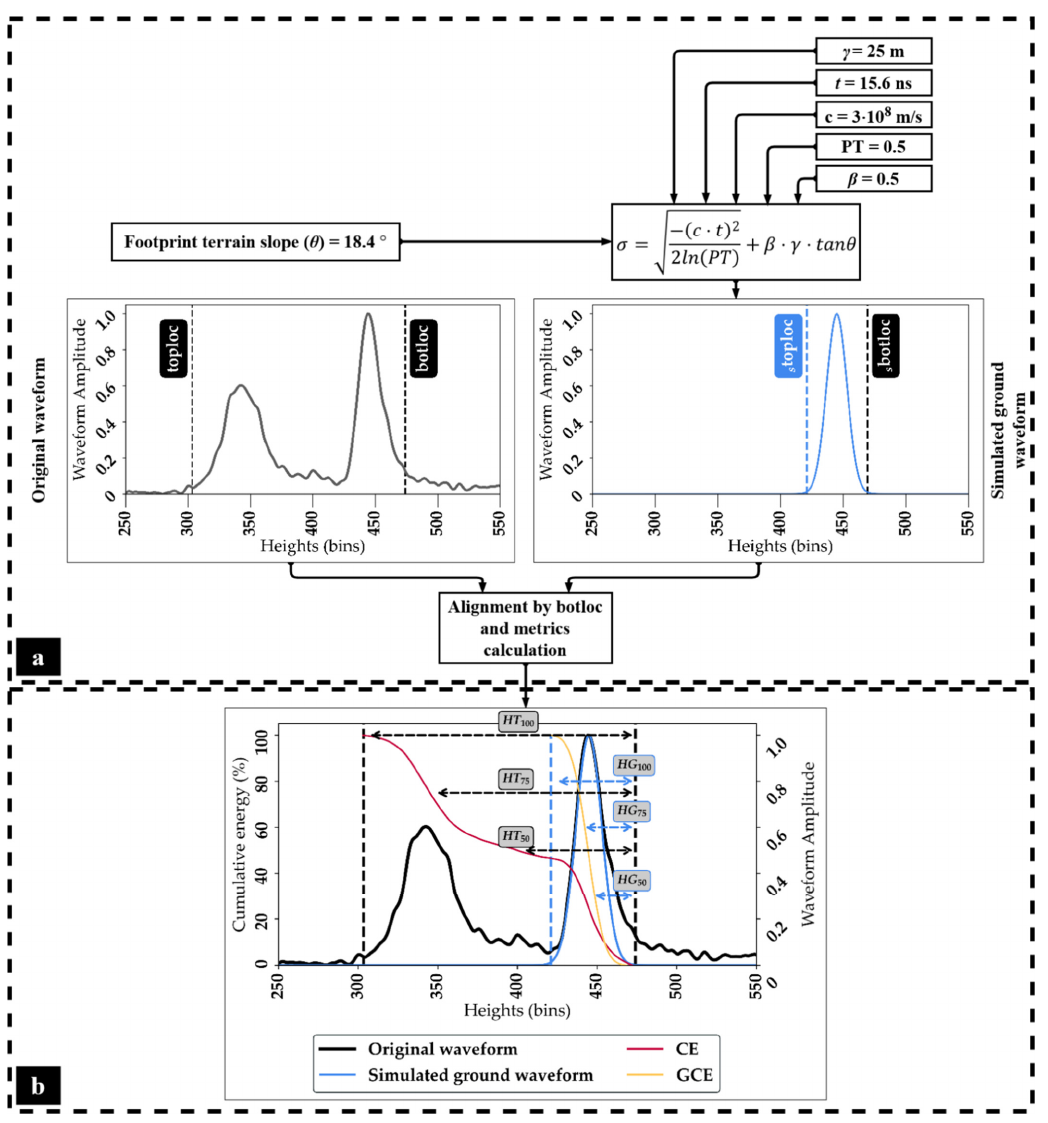
Figure 5. ( a ) Overview of the methodology for the simulation of the ground return as defined by Wang et al. [26] for a GEDI footprint acquired at 18.4° terrain slope. ( b ) The extracted canopy height metrics. CE represents the cumulative energy (from botloc to toploc ) of the original waveform. GCE represents the cumulative energy of the simulated ground waveform. The dashed lines represent the toploc and botloc positions.